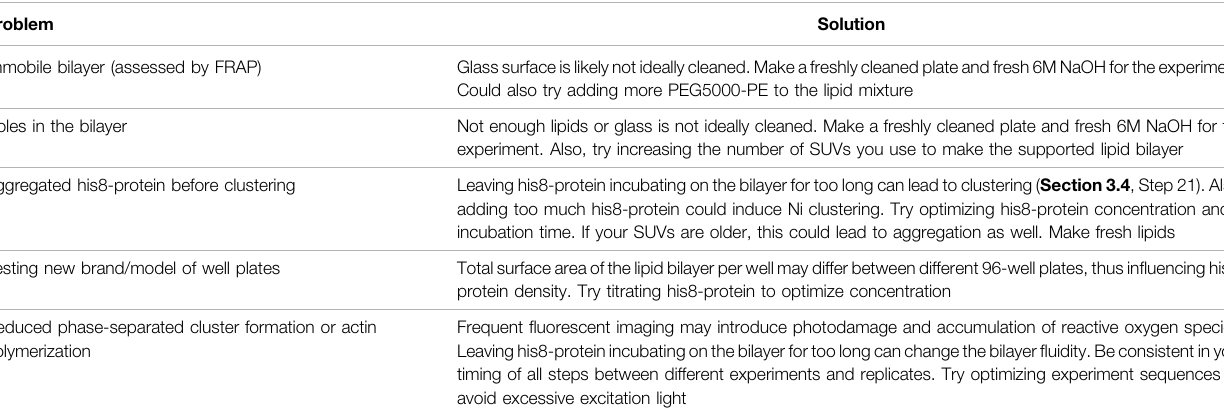
TABLE 6 | Troubleshooting guide. Problem